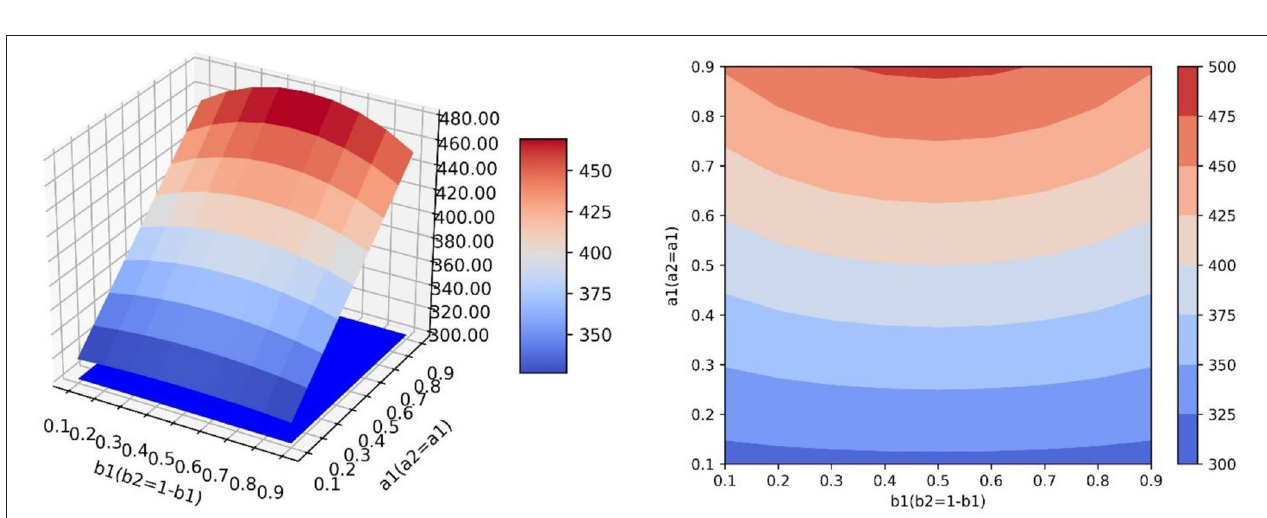
FIGURE 7 | In the scene of simulation 2, the value of positive emotion at the equilibrium point: surface graph and surface projection.